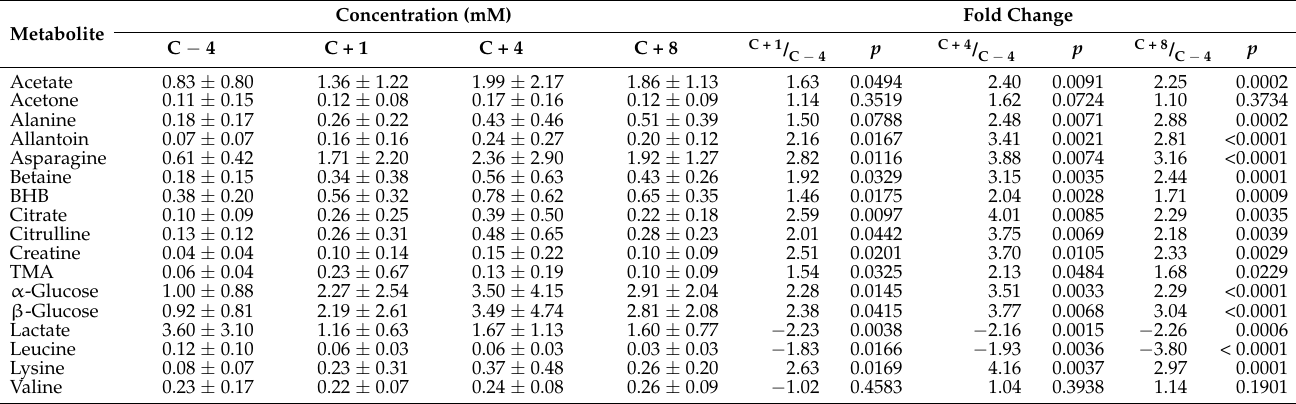
Table 2. Average metabolite concentrations during peripartum determined by 1 H NMR (mean ± std. dev.) and fold changes with respect to prepartum